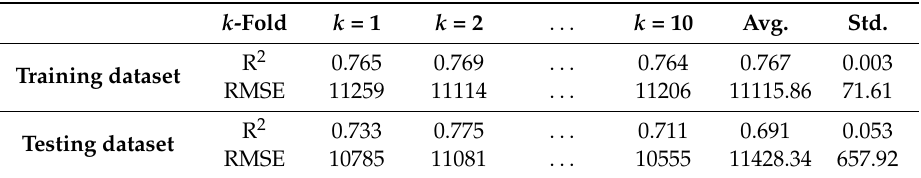
Table 8. 10-fold CV of OLS.